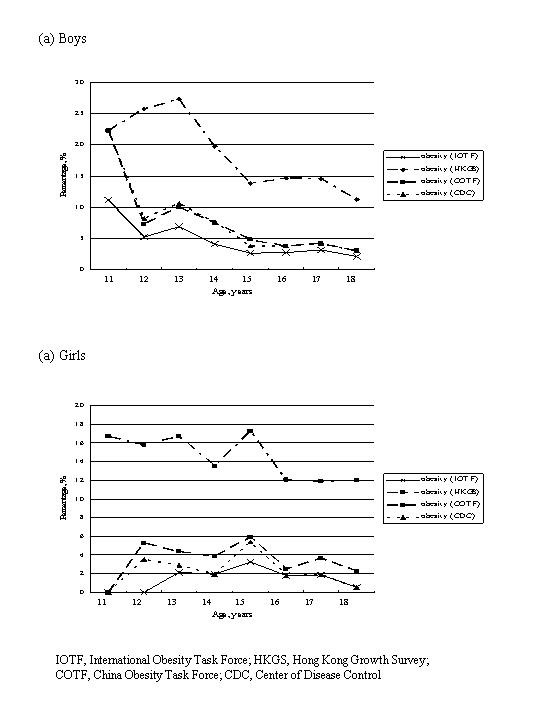
Percentages of obesity as defined by various criteria in 2098 Hong Kong Chinese adolescents categorized by age and gender.